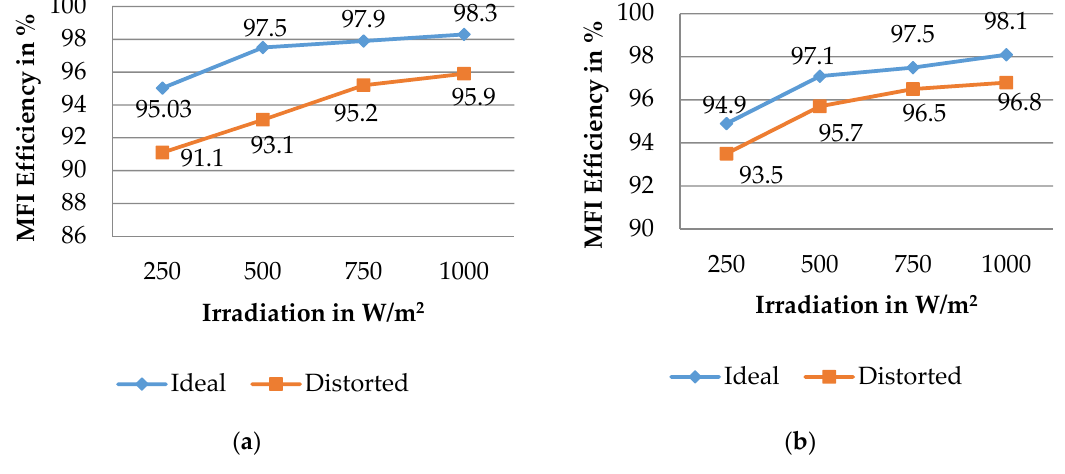
Figure 17. MFI efficiency using VDB-HCC: ( a ) full load; ( b ) reduced load.